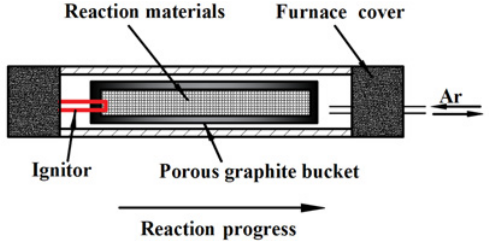
Fig. 1 Set-up for SHS